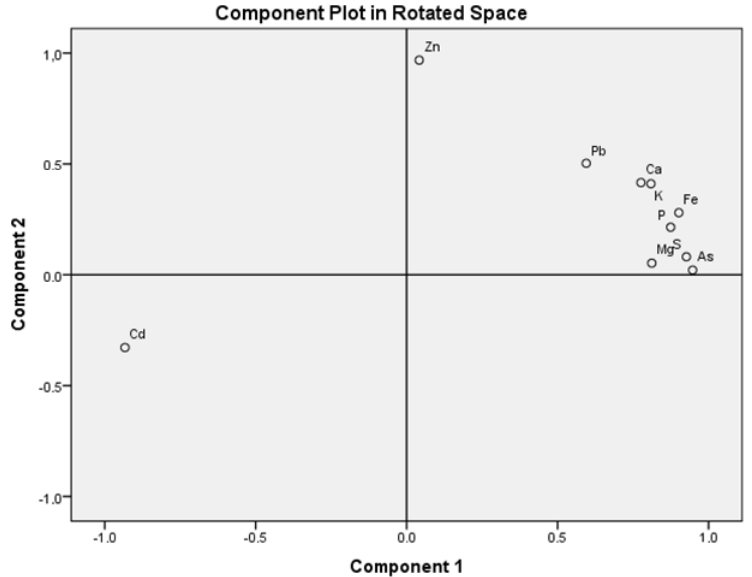
Figure 2. Projection of the factorial plane created with F1 (71.4% variance) and F2 (11.2% variance) axes of the macro and microelements of soil samples (n = 9) of Field A. (Observation: Eigenvalues are greater than 1 only in F1 and F2.)